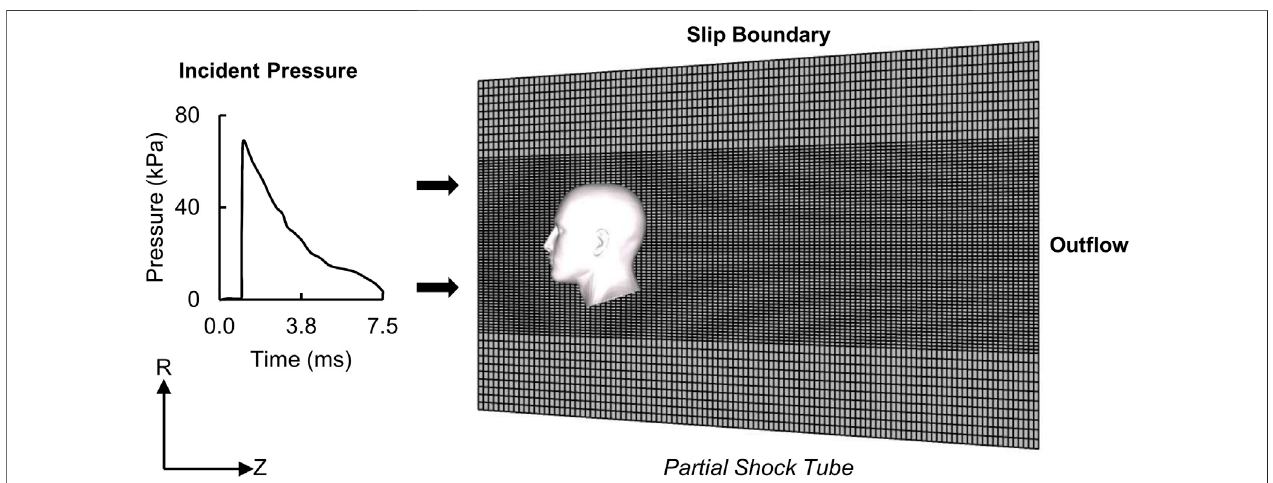
FIGURE 2 | Representation of the human-head fi nite-element (FE) model, partial shock tube FE mesh, and boundary conditions for the blast-loading simulations. (R: radial direction; Z: axial direction.).